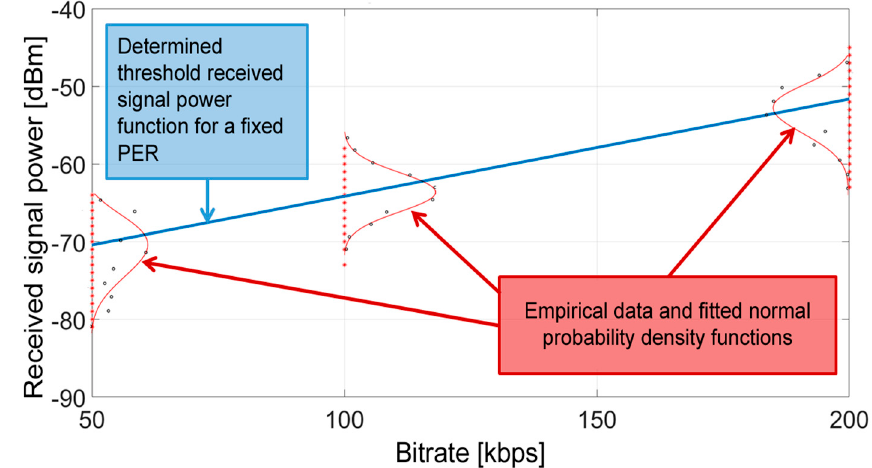
Figure 5. The method for determining the noise characteristics of the NB interface from the data of empirical measurements for an exemplary PER = 10 − 3 .